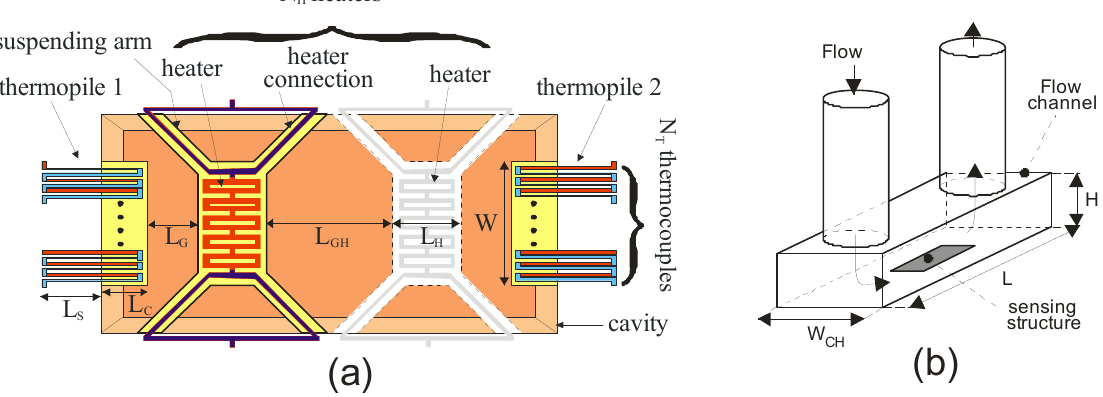
Figure 1. ( a ) Schematic view of a thermal flow sensor, based on a calorimeter type configuration with the main dimensions indicated; ( b ) Representation of the flow